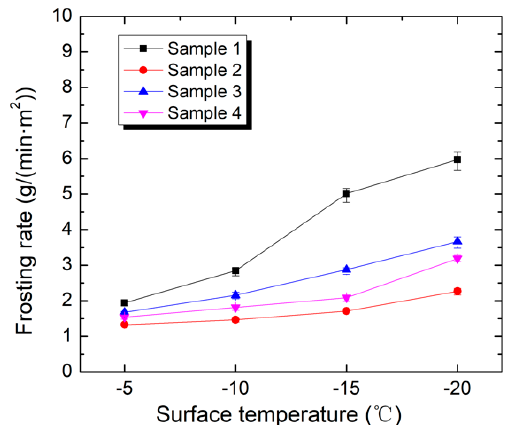
Figure 7. The frosting rate of the different aluminum sheets under different surface temperatures.